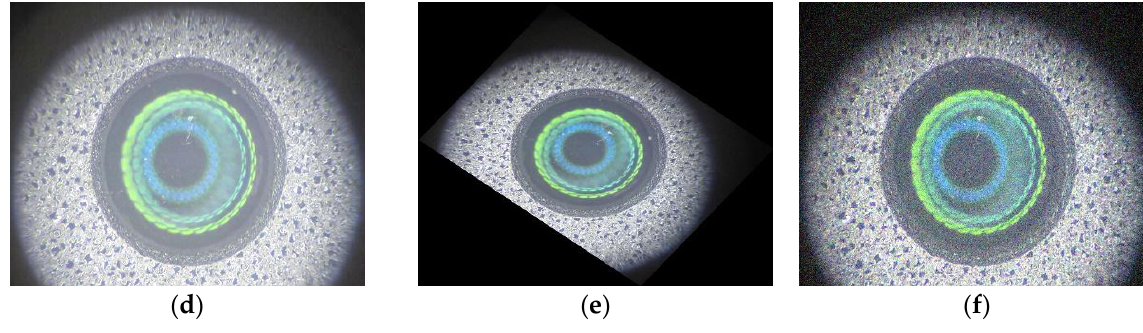
Figure 3. Effect of image enhancement. ( a ) Original image. ( b ) Cutting. ( c ) Flip. ( d ) Transformation of color gamut. ( e ) Rotation. ( f ) Adding noise.